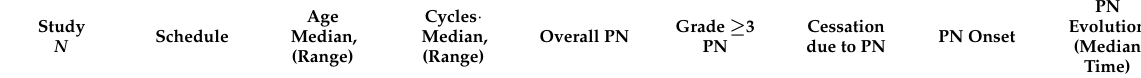
Table 1. Incidence and severity of BV-induced PN in R/R cHL in the adult population. Publications released worldwide reporting on PN toxicity and including > 20 patients with R/R HL are